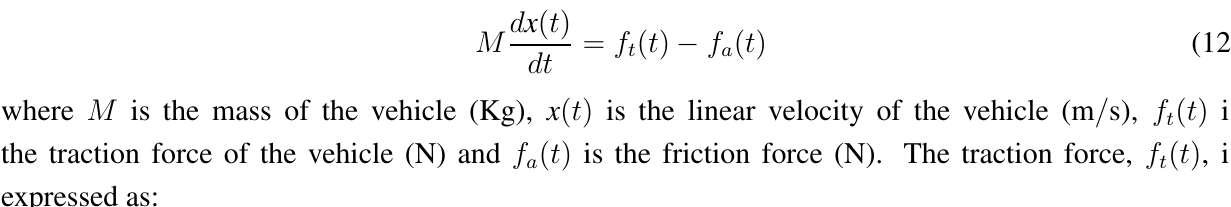
( t ) ), and one output, o